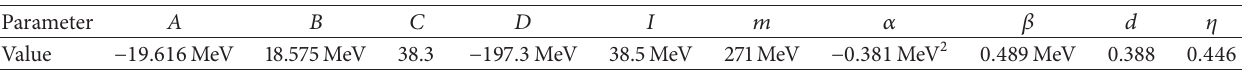
Table 2: The fitted values of the parameters of (22) for 𝑁 , Δ , Λ , Σ , Ξ , and Ω baryons, obtained with resonances mass differences and global fit to the experimental resonance masses [42].